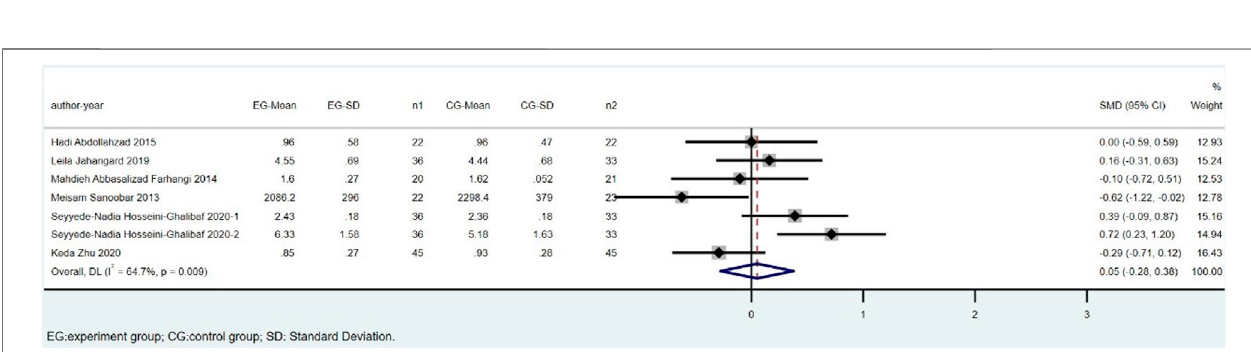
Frontiers in Pharmacology |